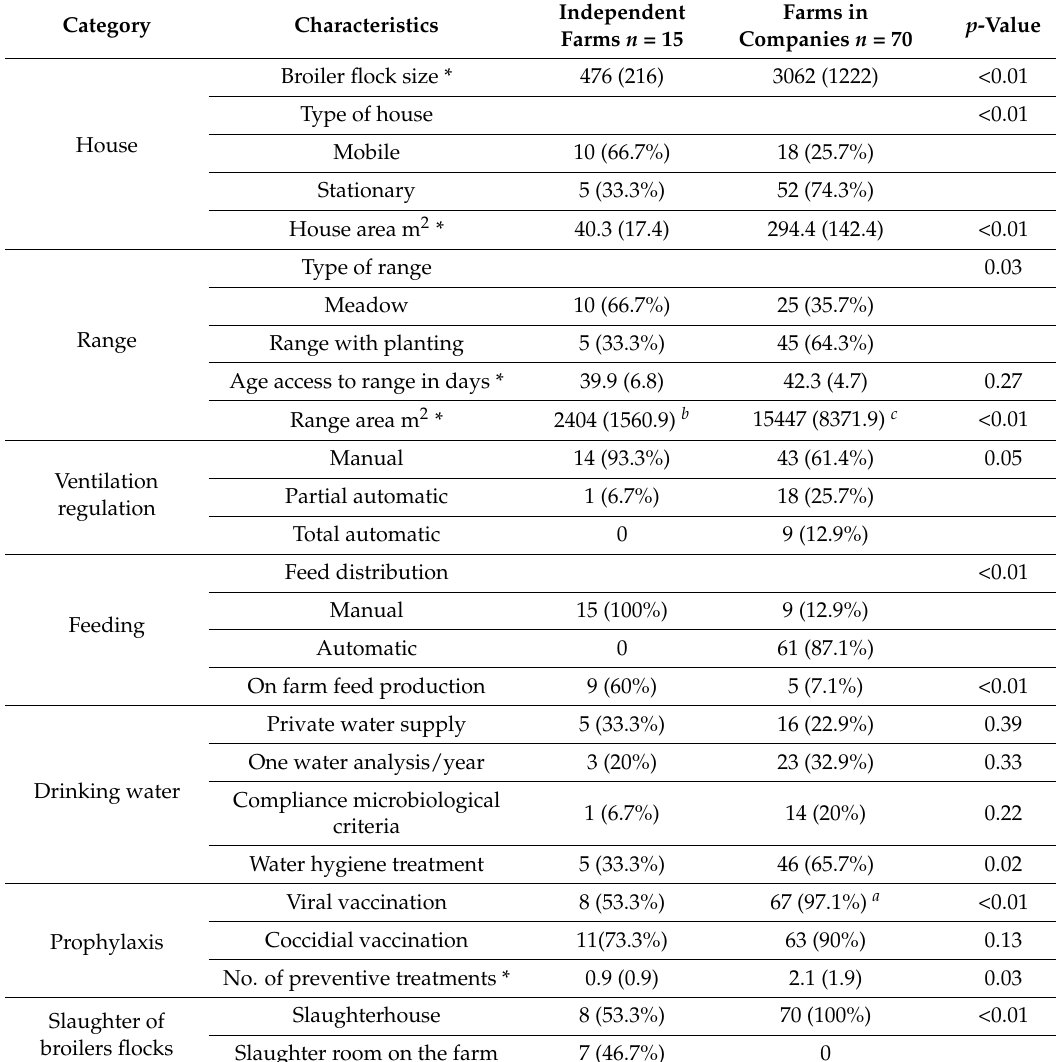
Table 3. Housing conditions and husbandry practices of the organic broiler flocks ( n = 85, France, 2015).